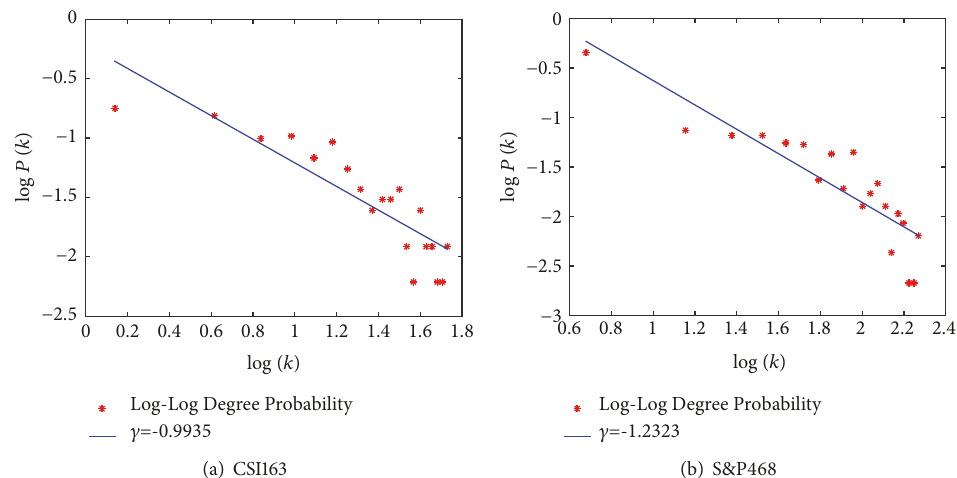
Figure 3: Log-Log degree distributions of CSI163 and S&P468 networks. By using different 𝜃 , we can filter out edges with larger distances. We find that not all the filtered networks can demonstrate the power law degree distributions. Only when 𝜃 falls within a narrow interval around 0.7, the filtered networks follow the power law degree distribution. In Figure 3(a), for the CSI163 network, we use 𝜃 = 0.68 and we get a fitting line with a slope of 𝛾 = −0.9935 . In Figure 3(b), for the S&P468 network, we use 𝜃 = 0.75 and we get a fitting line with a slope of 𝛾 = −1.2323 . This indicates that the degree distributions of both stock markets follow the power law in the form of 𝑃(𝑘) ∼ 𝑘 −𝛾 , which also means the networks are scale free in which a small portion of vertices have larger degrees, while a large portion of vertices have small